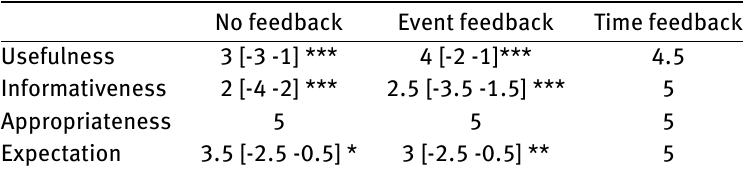
Table 2: Median Likert-scale responses for each condition with 95 % confidence intervals on the median of the difference for the planned comparisons. Statistical significance levels: * p < 0.05, ** p < 0.01, *** p <